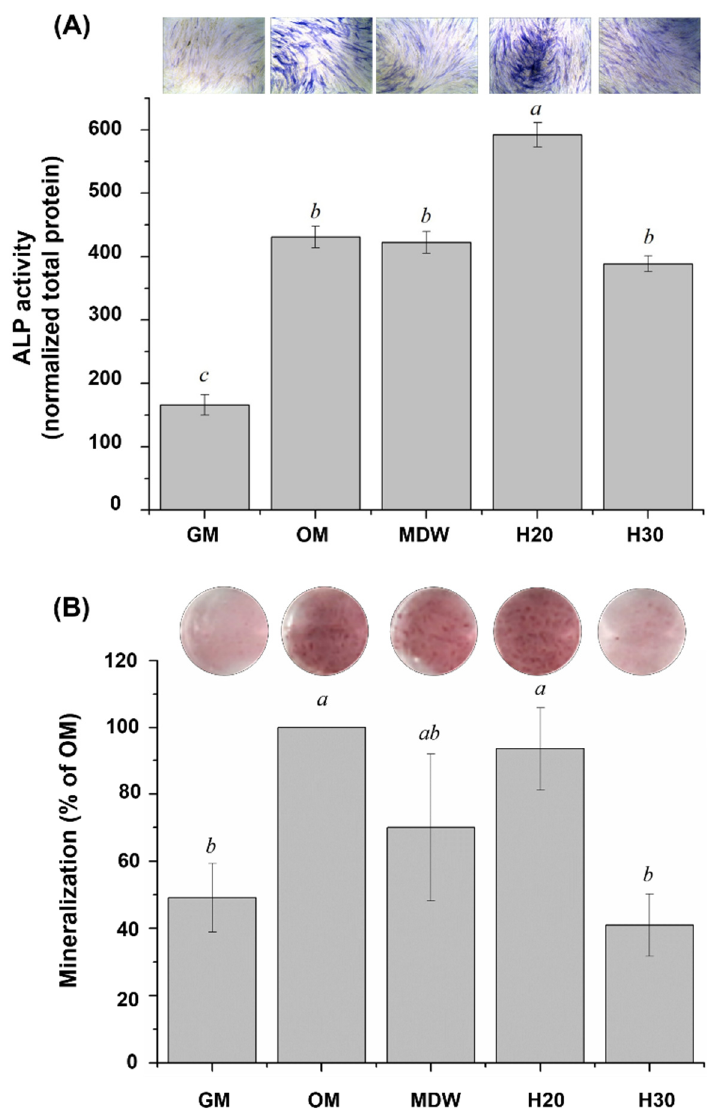
Figure 5. Osteogenic properties of control and experimental groups. ( A ) ALP staining and activity, highlighting significant difference of H20 group ( p < 0.05). ( B ) Mineralization, highlighting a higher but insignificant difference of H20 group. Different small case letters indicate statistically significant differences between the groups with analysis of variance and Tukey’s post-hoc. GM; growth medium, OM; osteogenic medium.